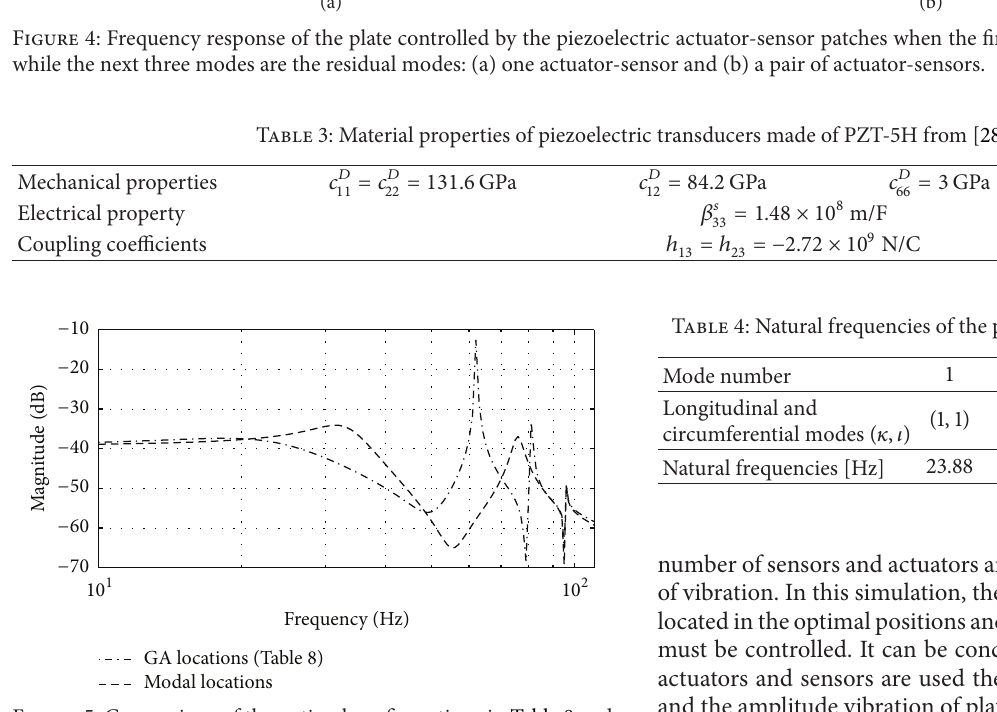
Figure 5: Comparison of the optimal configurations in Table 8 and use of the optimal locations of one actuator activated for the first mode and the other actuator for the second mode.